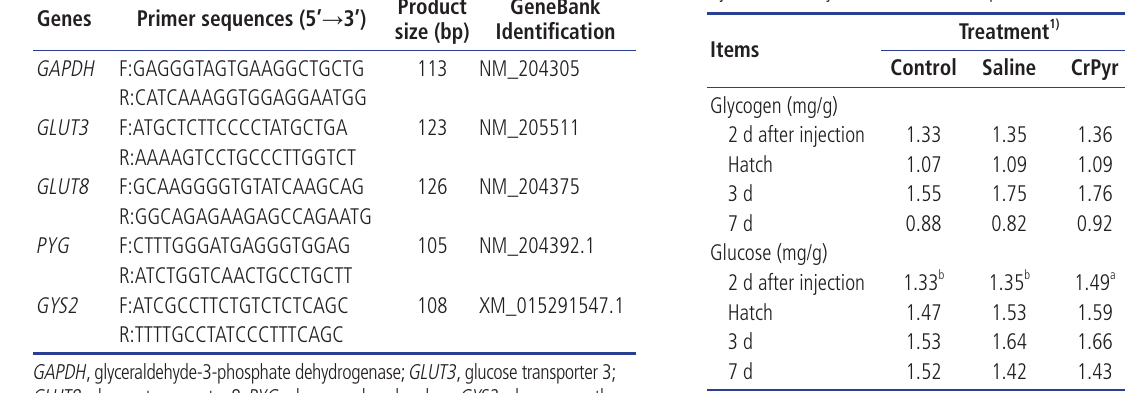
Table 2. The primer sequences for real-time quantitative polymerase chain reaction analysis Genes Primer sequences (5’ → 3’) GAPDH F:GAGGGTAGTGAAGGCTGCTG 113